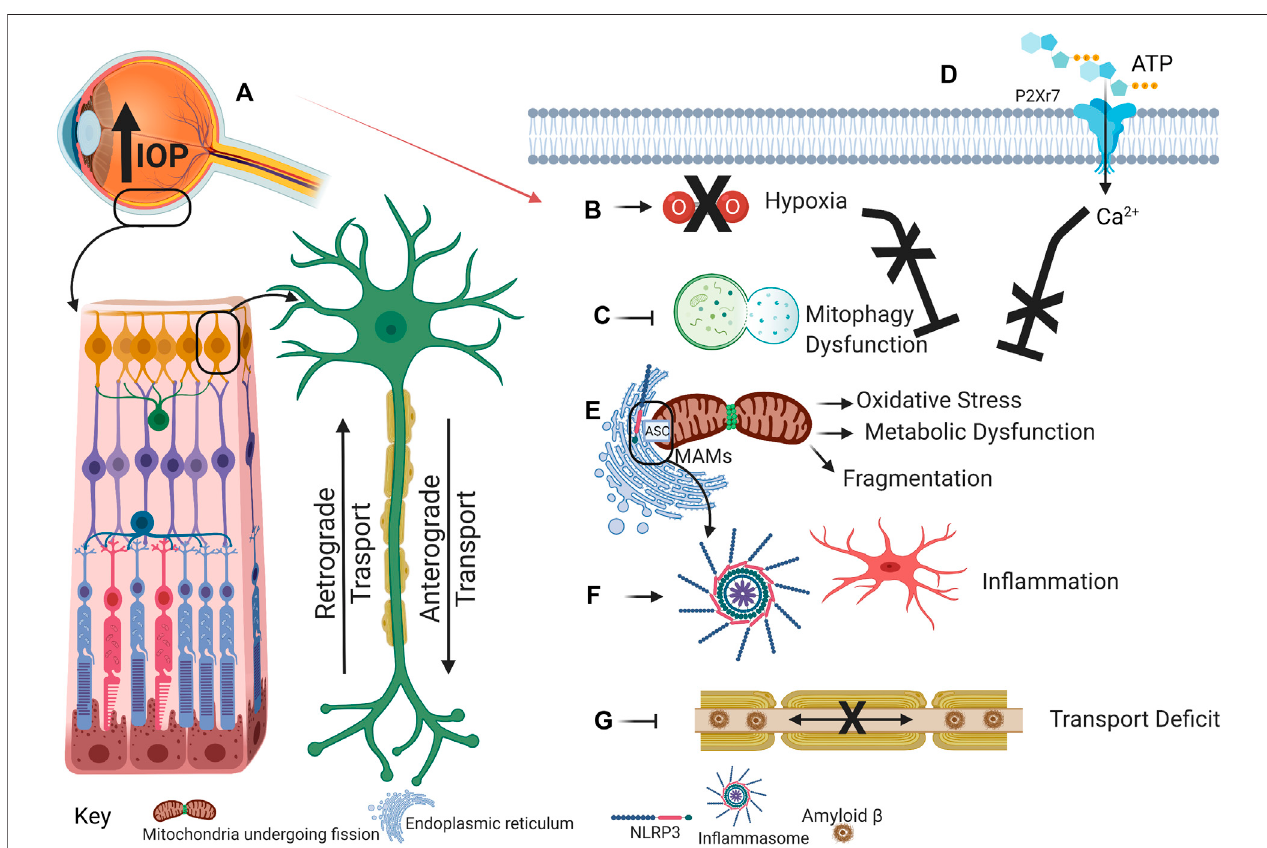
FIGURE1| Thisschematicillustratestheproposedcascadeofeventsthatlinktheincreasedintraocularpressureofglaucomatomitochondrialdysfunctionandthe NLRP3 in fl ammasome. (A) Intraocular pressure increases as aresult ofperturbed aqueous humor out fl ow inthe eye. (B) Intraocular pressure increase prevents ef fi cient blood fl ow to the eye, resulting in hypoxia/ischemia. During physiological conditions, hypoxia induces mitophagy to eliminate dysfunctional mitochondrial accumulation. (C) However, during glaucoma, hypoxia-induced mitophagy may be inhibited. Concomitantly, external ATP binds to and opens the cation-selective P2X7R (D) . Ca 2+ in fl ux can stimulate mitochondrial dysfunction that will induce in fl ammation, activated microglia, and cytokine release. (E) Dysfunctional and fragmented mitochondria accumulate, thus promoting oxidative stress and metabolic vulnerability. Oxidative stress induces in fl ammasome assembly and activation as NLRP3, localized at the ER, comes into proximity to the ASC, localized at the mitochondria, on MAMs. (F) In fl ammasome activation releases cytokines that establish a positive feedback loop to exacerbate further in fl ammatory response. (G) A β that has been demonstrated in mitochondria can also accumulate in axons, thereby inducing axon transport de fi cit that further contributes to glaucoma progression. Created with Biorender.com